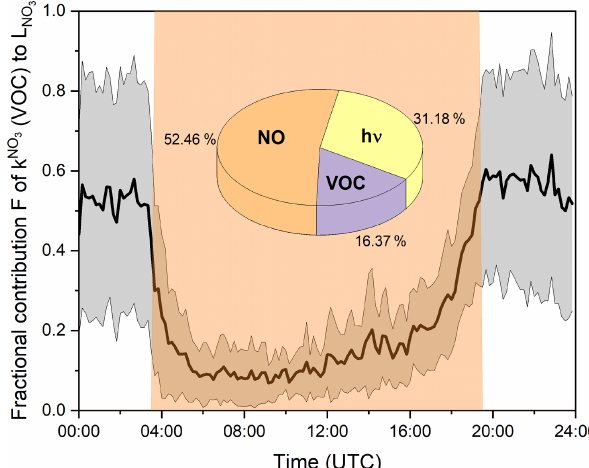
Figure 7. Mean fractional contribution ( F ) of k NO 3 (i.e. VOC con- tribution) to the overall NO 3 loss rate over the diel cycle. The grey shaded area represents the standard deviation (1 σ ) of the mean val- ues. Orange shaded area indicates daytime. The pie chart shows the mean fractional contribution to the NO 3 loss in the reaction with NO, photolysis, and the reaction with VOCs during the